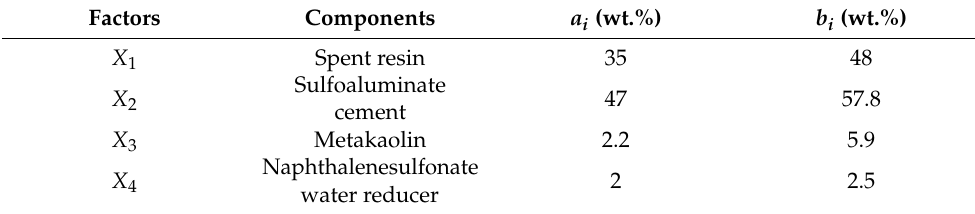
Table 1. Upper and lower limits of factors.